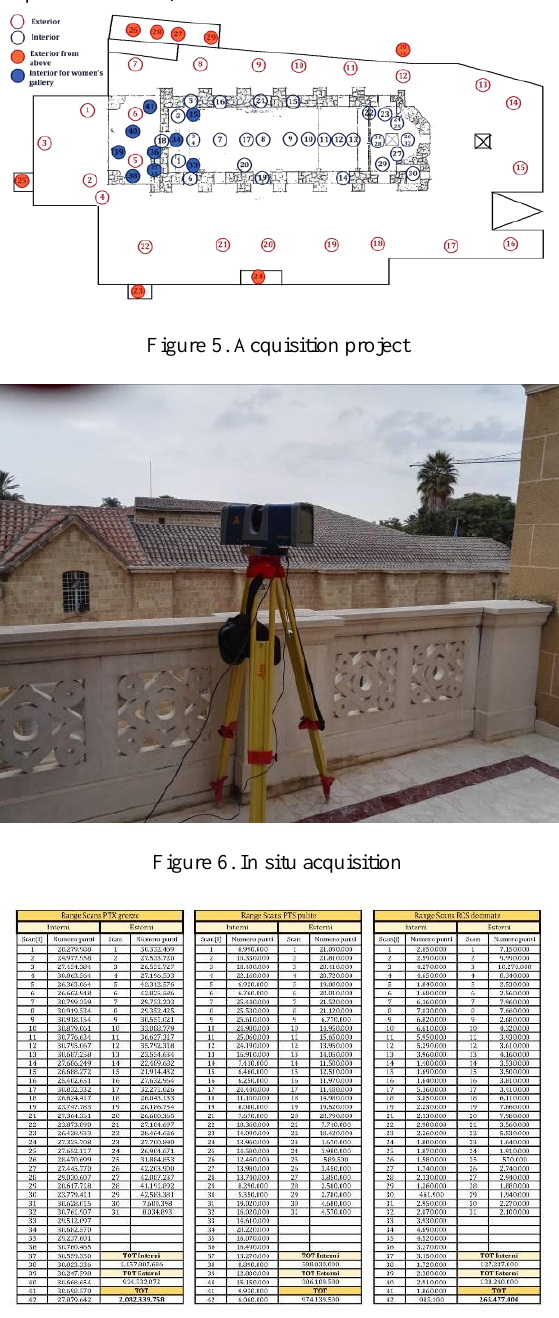
Figure 7. Results of points cleaning and